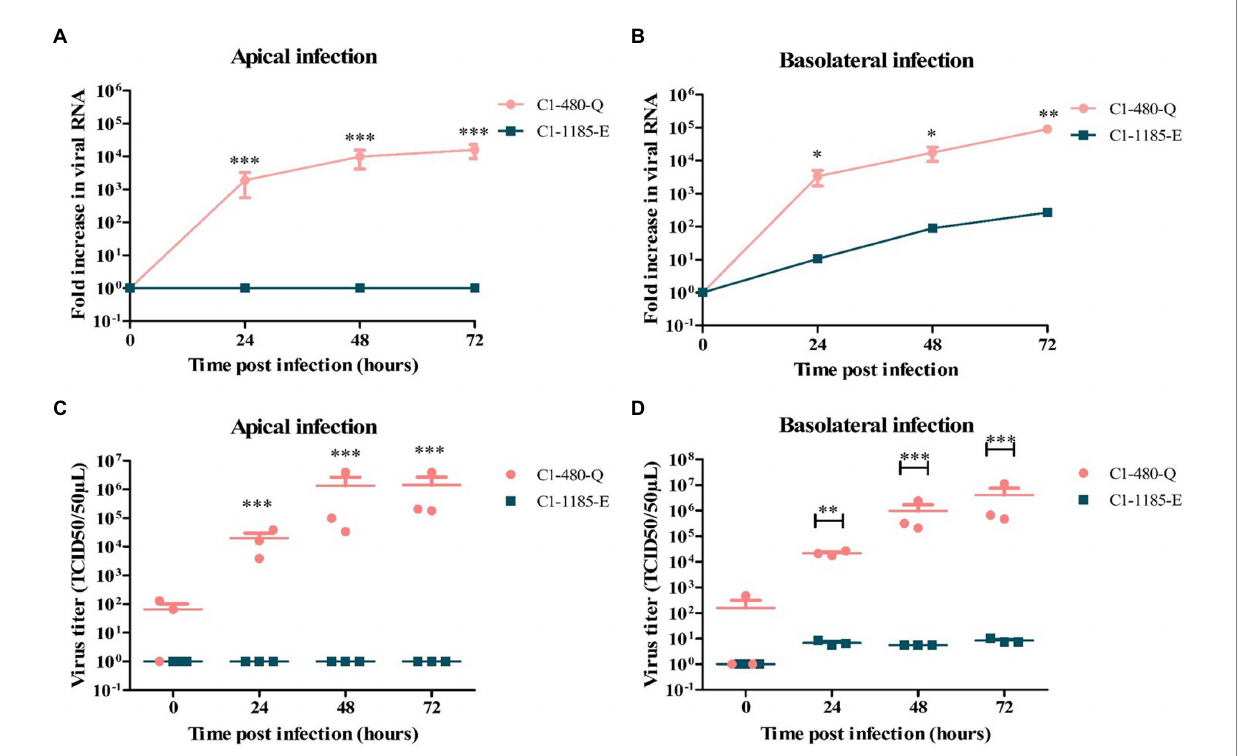
FIGURE 1 Replication kinetics of EV-A71 clinical isolates C1-480-Q and C1-1185-E in fetal intestinal organoid-derived monolayers. Fold increase in viral RNA copies and virus titers in media collected at different time points from the apical surface after apical (A,C) and basolateral (B,D) inoculation, respectively. In all cases, data represent the geometric mean ± SEM of four biological replicates with two technical replications per biological replicate. * value of p < 0.05; ** value of p < 0.01; *** value of p <